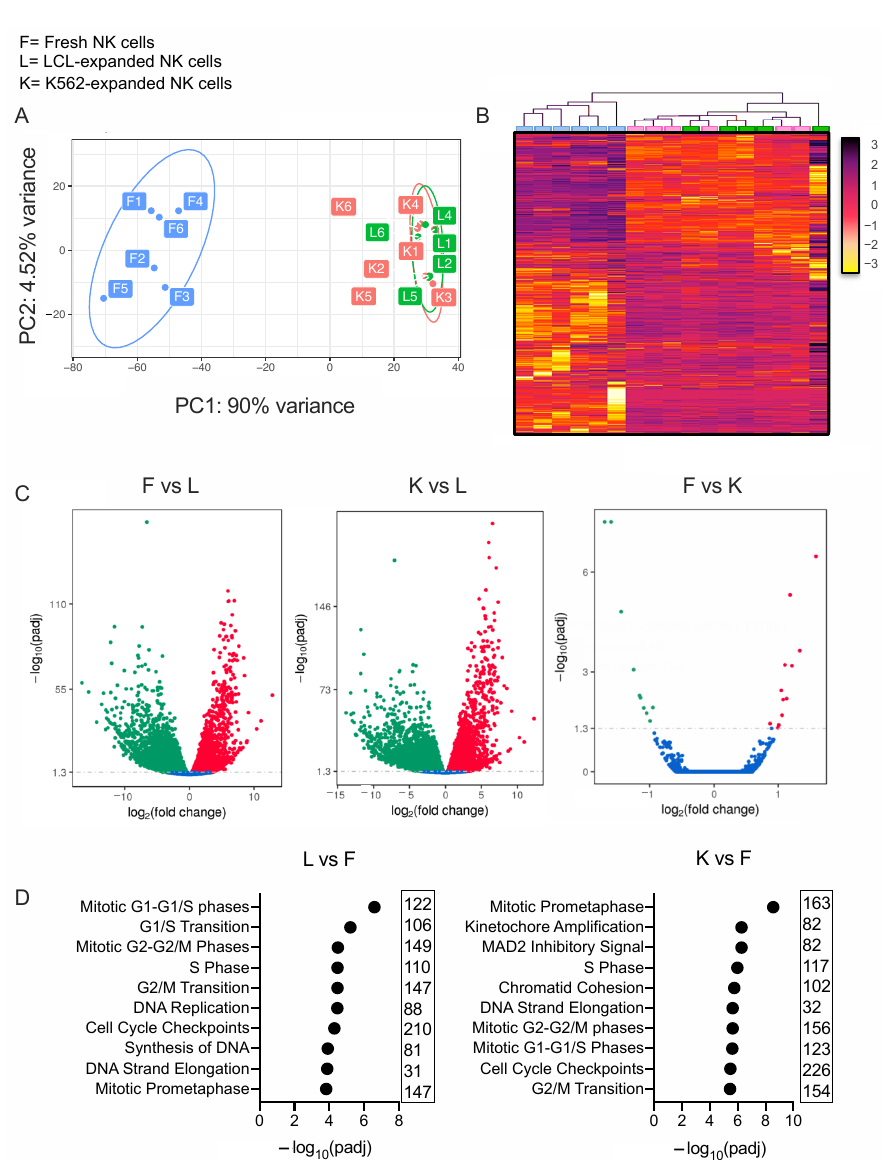
Figure 1. Ex vivo expansion heavily alters the natural killer (NK) cell transcriptional landscape. F = freshly isolated and rested NK cells, L = lymphoblastoid cell line (LCL)-expanded NK cells and K= genetically engineered K562 (GE-K562)-expanded NK cells. ( A ) Principal component analysis of fresh and expanded NK cells. ( B ) Unsupervised gene clustering of fresh and expanded NK cell populations (color scale represents relative gene expression). ( C ) Volcano plots to illustrate the distribution of significance ( − log 10 (adjusted p value)) and change in expression (log 2 (fold change)) of differentially expressed genes within the comparisons. ( D ) Gene ontology enrichment analysis of top significant gene groups that are differentially